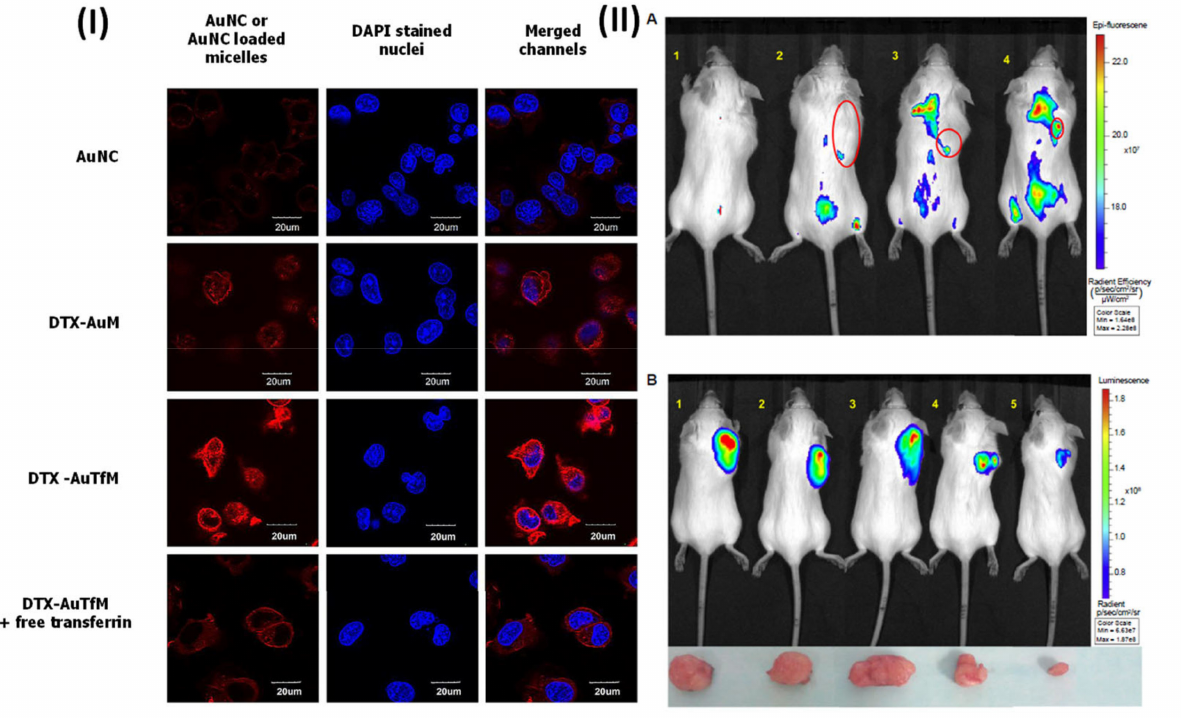
Figure 5. ( I ) CLSM photograph in breast cancer cells; ( II ) ( A ) Mice with tumors imaged and treated with fluorescent targeting fluoroscopy; ( II ) ( B ) Bioluminescent photos of tumor regression in live mice. Reproduced with the permission from Ref. [86], Figures 5 and 8 (Elsevier